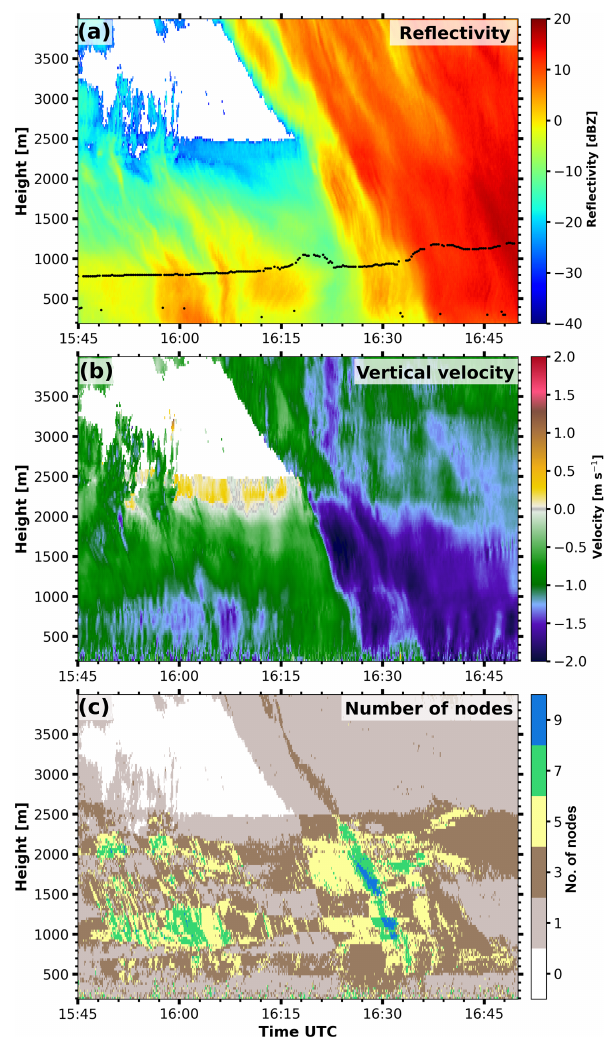
Figure 4. KAZR reflectivity with lidar-detected cloud-base height (black dots, a ), mean velocity (b) and number of nodes (c) on 2 February 2014 from 15:45 to